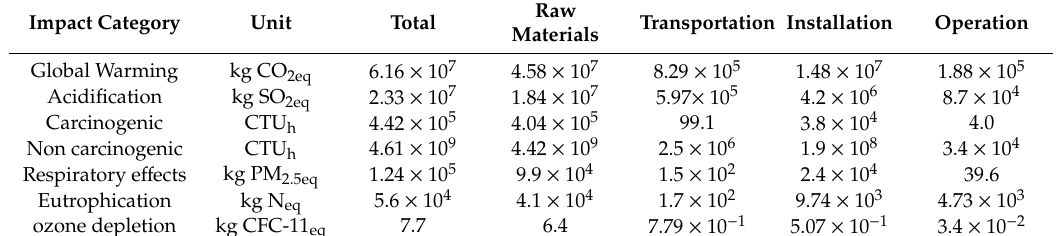
Table 8. Analyzing ‘TWF-Phases’; Method: TRACI / Characterization.